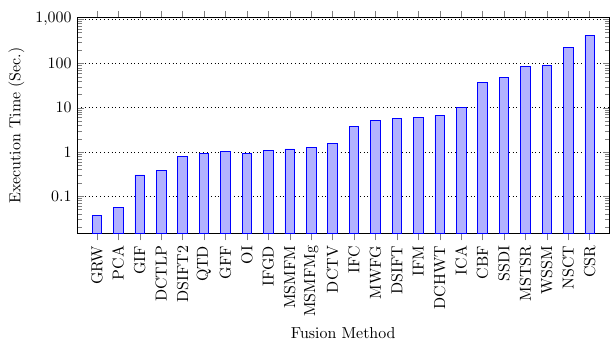
Figure 10. Execution time comparison of the compared